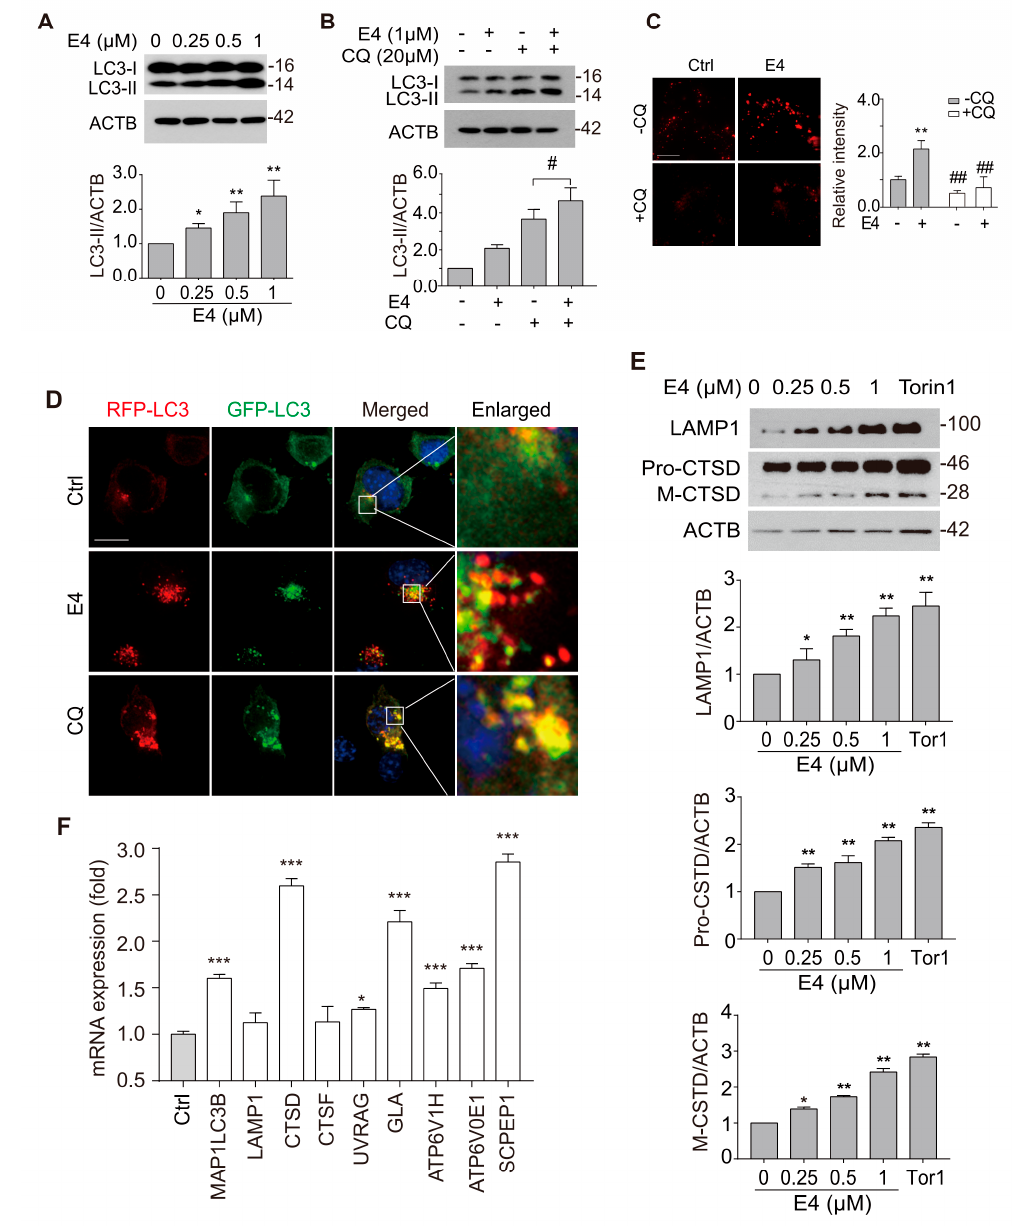
Figure 2. Compound E4 promoted autophagy flux and lysosomal biogenesis. ( A ) E4 dose-dependently increased the level of LC3B-II compared with vehicle control (0.1% DMSO). The expression of LC3-II in N2a cell after being treated with di ff erent concentration of E4 for 24 h were detected by Western blotting. Relative intensity of LC3B-II is normalized to that of β -actin / ACTB. Data are presented as mean ± SEM of three replicates in a representative experiment ( B ). The expression of LC3-II in N2a cell after being treated with indicated concentration of E4 and chloroquine (CQ) for 24 h were detected by Western blotting. Relative intensity of LC3B-II is normalized to that of β -actin / ACTB. Data are presented as mean ± SEM of 3 replicates in a representative experiment. ( C ) N2a cells were treated with vehicle control (0.1% DMSO), E4 (1 μ M), or CQ (20 μ M) for 12 hours and then stained with LysoTracker Red DND-99 (50 nM) for 30 minutes. Fluorescence intensity of treated